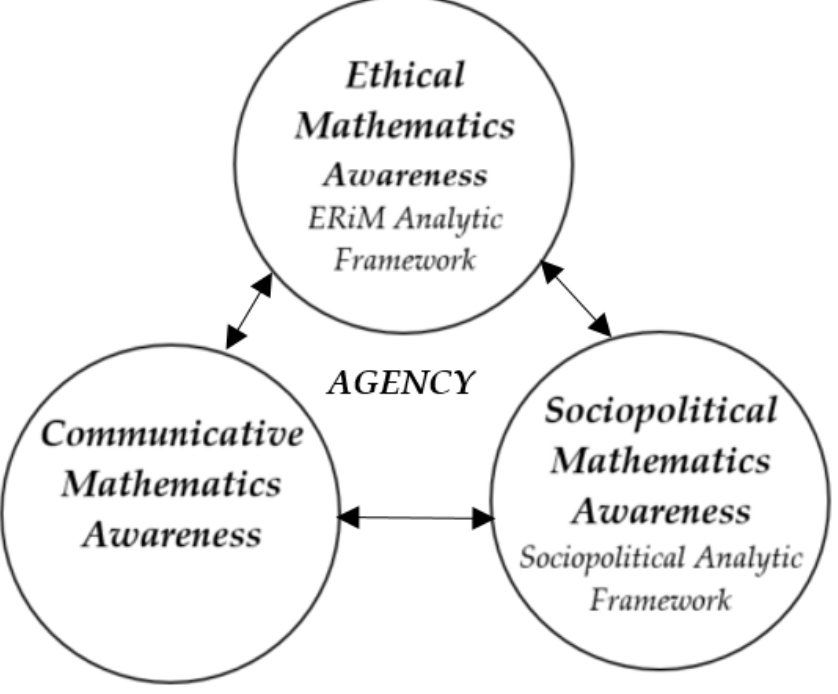
Figure 1. Critical Mathematics Consciousness Theoretical Framework.